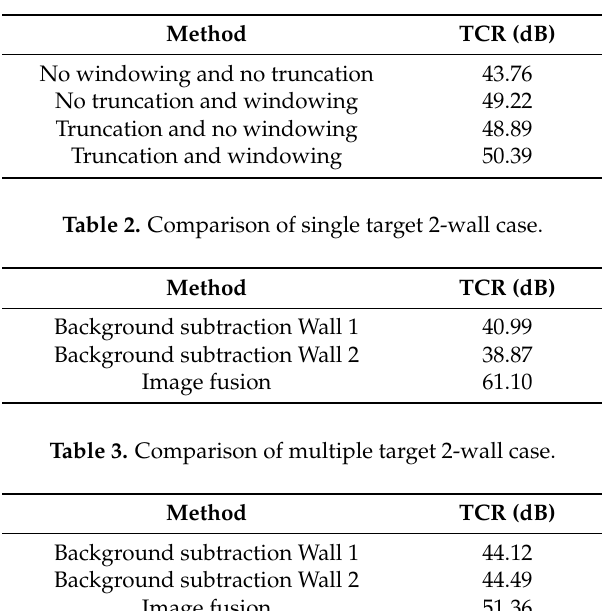
Table 1. Comparison of processing methods.